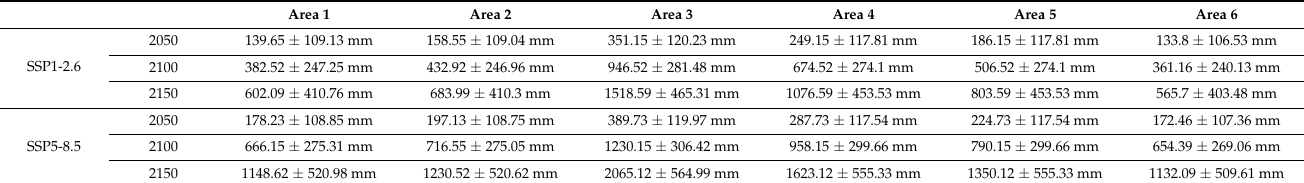
Table 2. Projections of sea-level rises for the areas of Tavoliere delle Puglie; SSP1-2.6 and SSP5-8.5 represent the low and high atmospheric-greenhouse-gas-concentration scenarios,